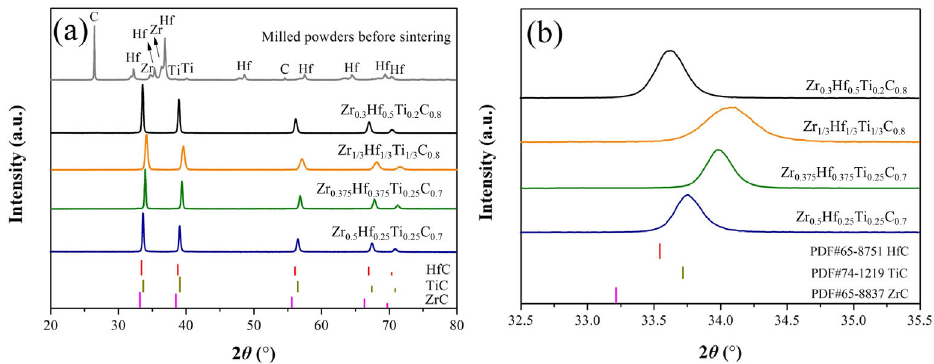
Fig. 4 XRD patterns of (a) (Zr,Hf,Ti)C x carbides and the milled powder of Zr 1/3 Hf 1/3 Ti 1/3 C 0.8 before sintering and (b) the enlargement of XRD patterns from 32.5° to